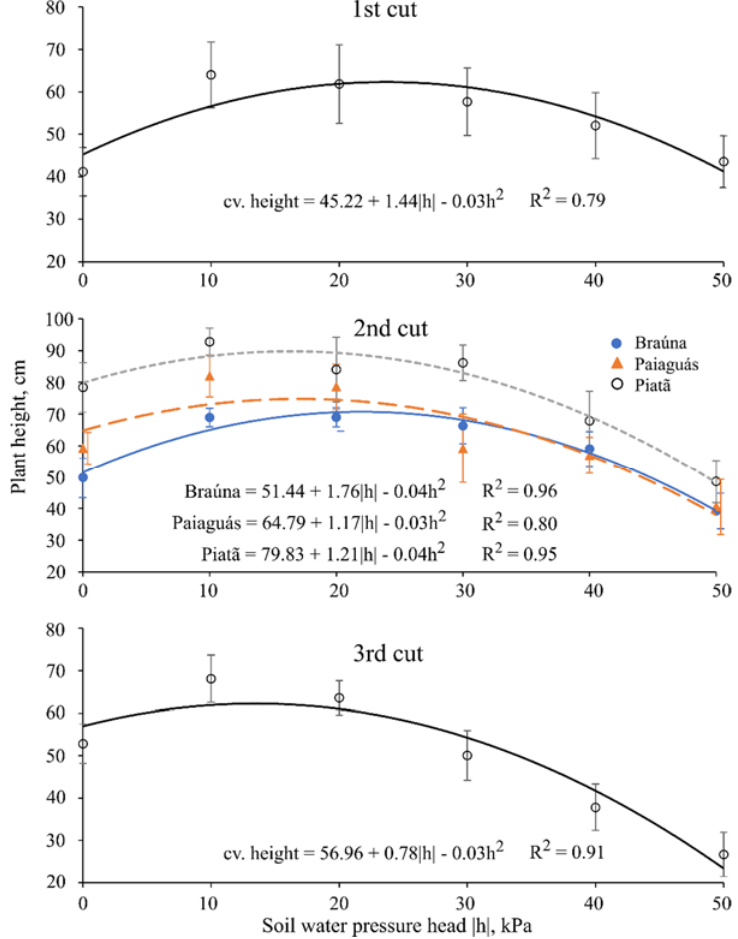
Figure 2. Regression models relating soil water pressure head to plant height of Brachiaria brizantha cultivars for the three cutting periods (40, 70, and 100 DAE (days after emergence)). Error bars correspond to the standard deviation of the four replicas.